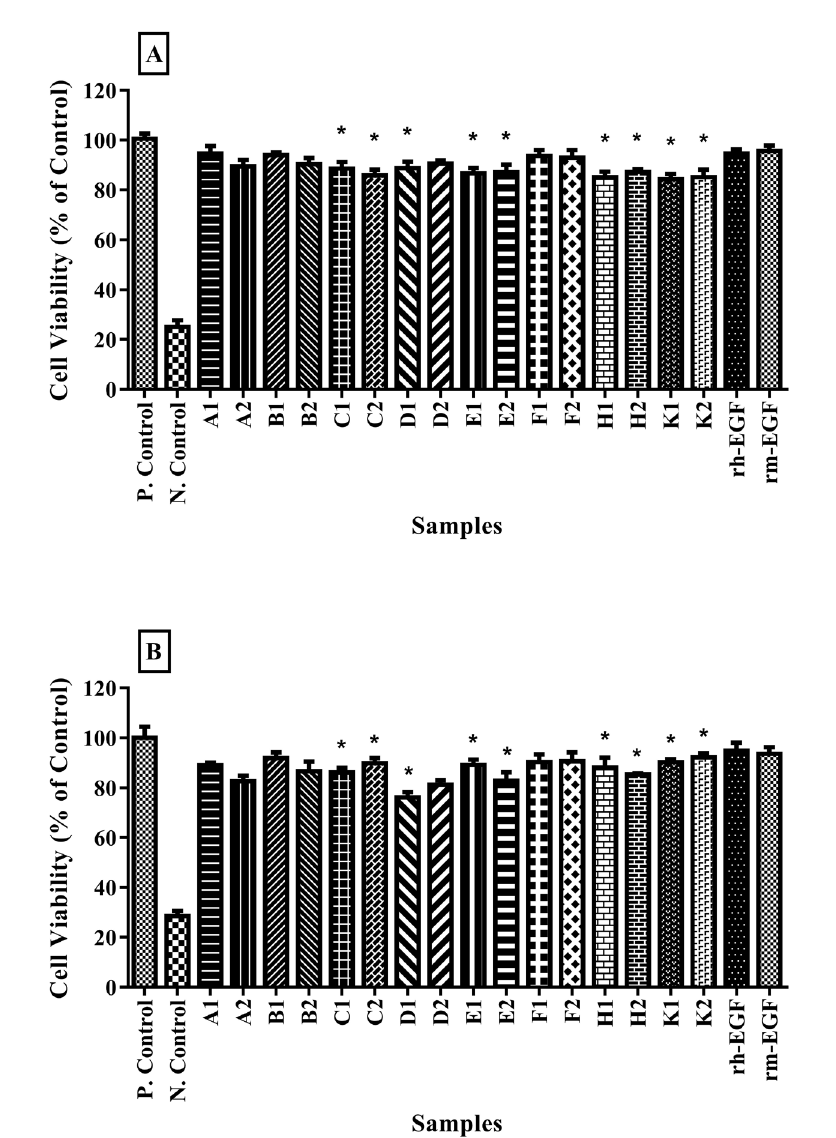
FIGURE 6 - MTT cell viability results of NIH 3T3 (A) and HaCaT (B) cell lines (n=3). Positive control (non-treated) group includes NIH 3T3 (A) and HaCaT (B) cells respectively. Negative control (non-treated) group does not include cells. Values are the mean of triplicate determination (n=3) ± standard deviation and statistically significant at * p<